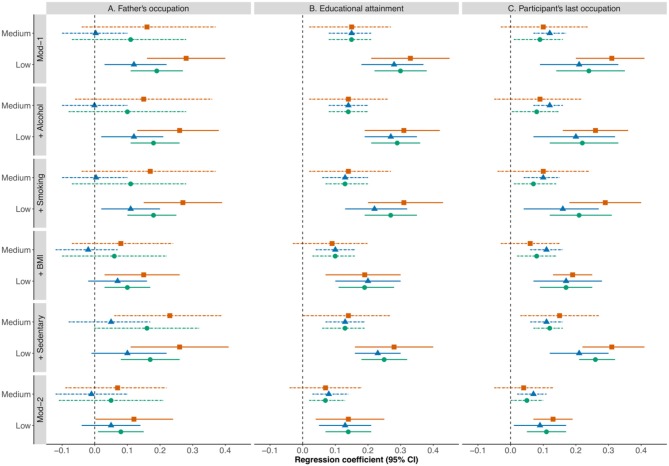
Meta-analysis of the association between CRP and SEP as measured by father's occupational position (A), own education (B), and own occupation (C) in the full study population (orange), men (blue), and women (green). Several models are considered and are gradually adjusted for exposures and behaviors (36).